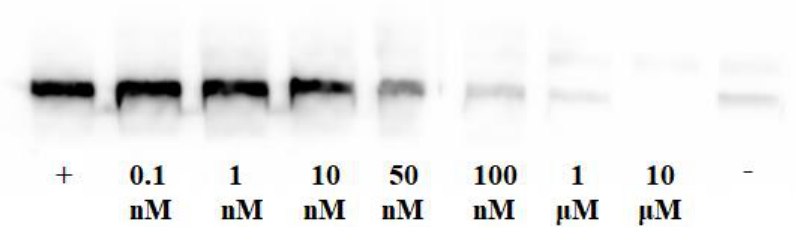
Figure 3. Inhibition of EGFR phosphorylation in A431 cells for complex 5a at a concentration range from 0.1 nM to 10 μM. Symbols + and - indicate the presence or absence of EGF in the experiment. IC 50 = 26.11 nM